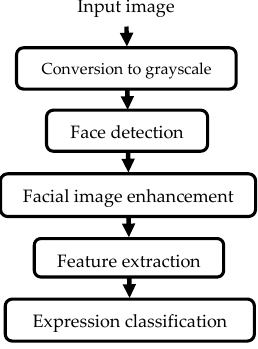
Figure 1. The steps of face recognition.